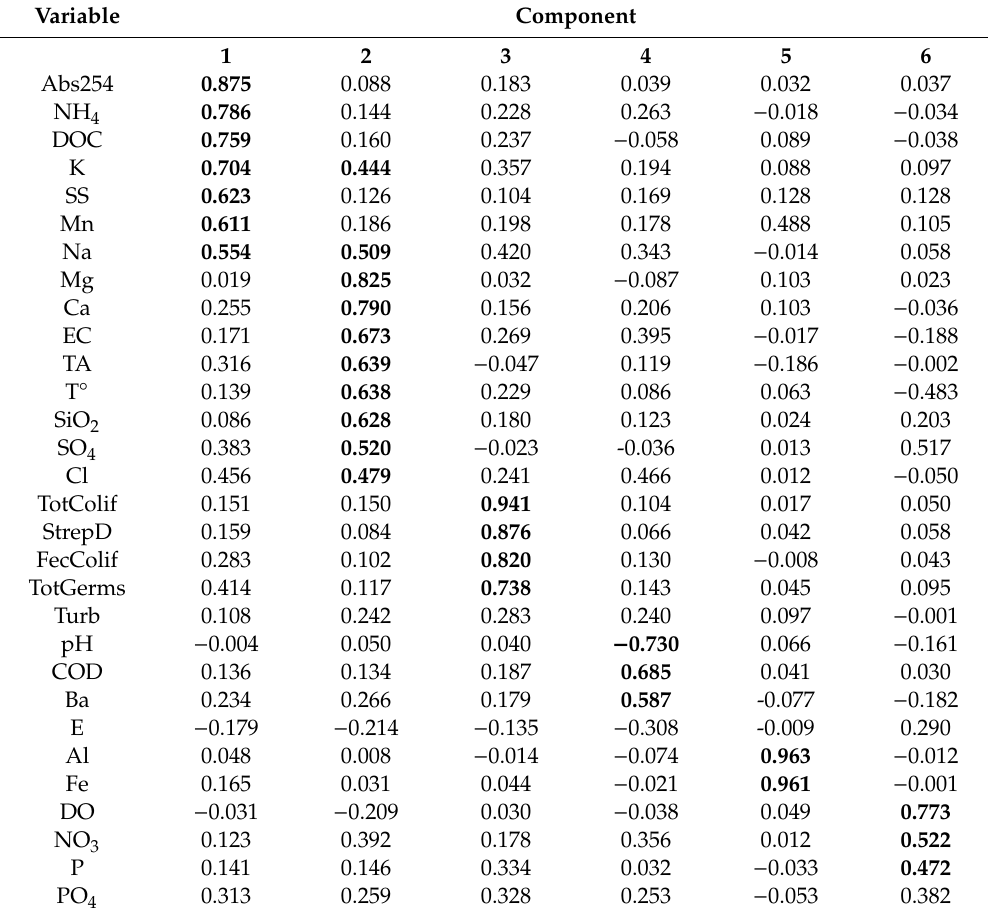
Table 2. Matrix of the first six components obtained for the general Principal Component Analysis (PCA) applied to the data matrix including the two rivers, all variables and all